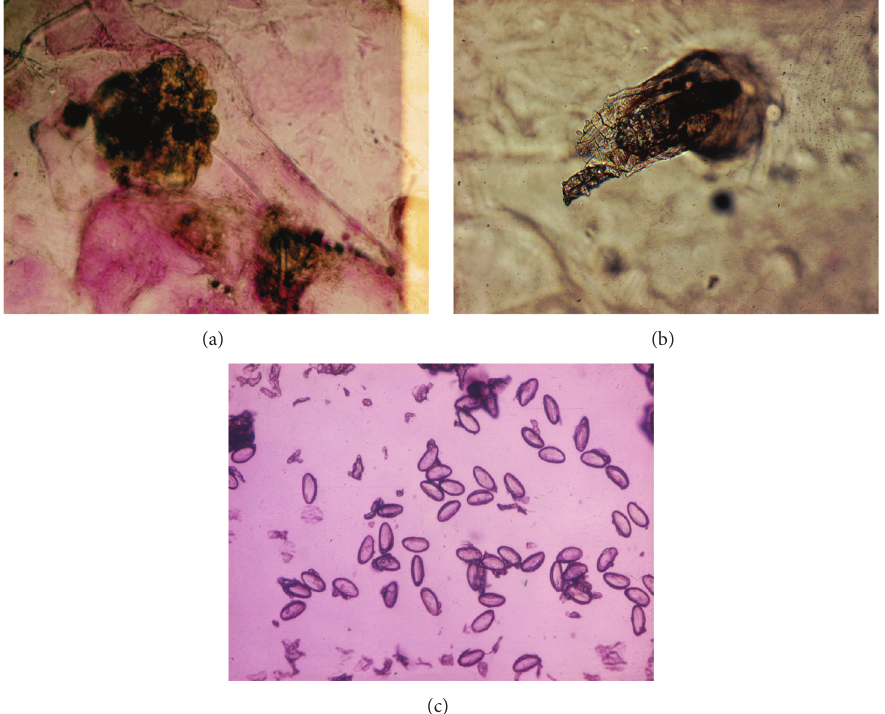
Figure 6: Superficial parasitoses. (a) Acarus scabiei. (b) Demodex folliculorum . (c) Oxyuriasis.